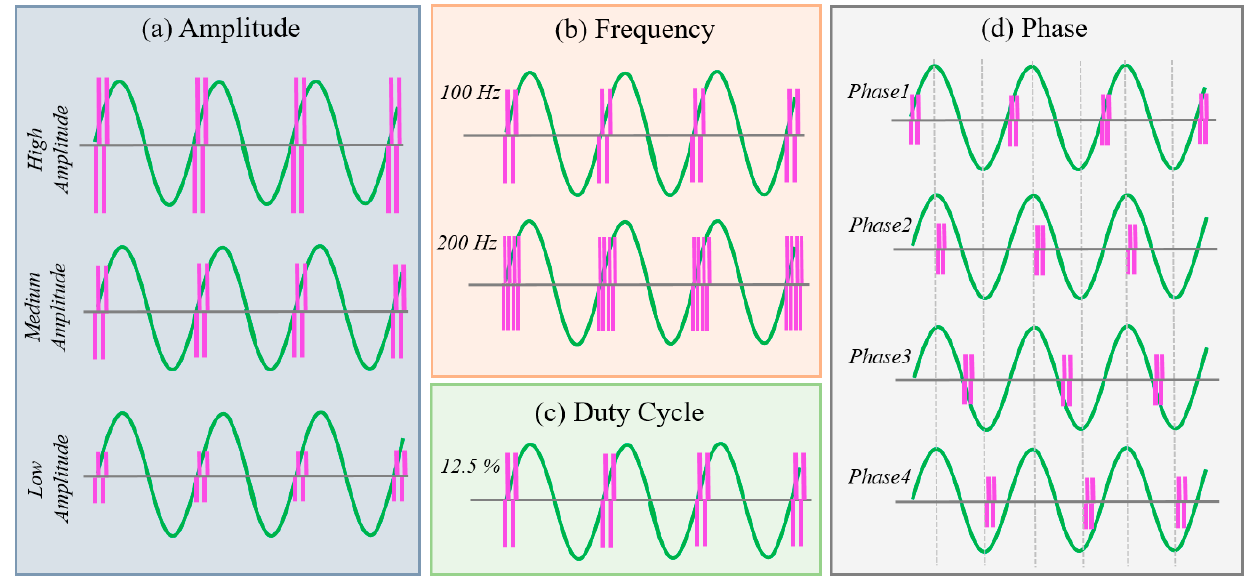
Figure 4. Stimulation parameters and their ranges: ( a ) amplitude, ( b ) frequency, ( c ) duty cycle, and ( d ) phase to the tremor cycle.